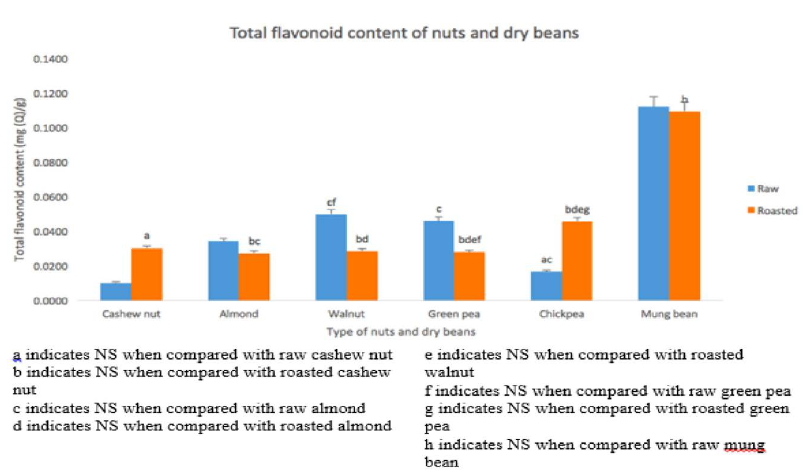
Fig. 4. TFC in raw and roasted dry beans and